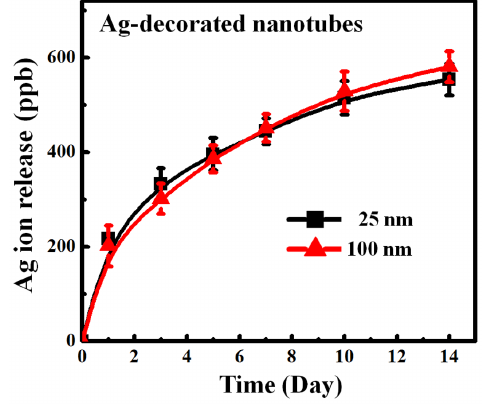
Figure 4. Optical images showing water droplets. On the as- grown ( A – C ) and Ag-decorated TiO 2 nanotubes before ( D – F ) and after UV light irradiation ( G – I ). The contact angles are denoted in the images. Data were means 6 SE of three independent experiments.